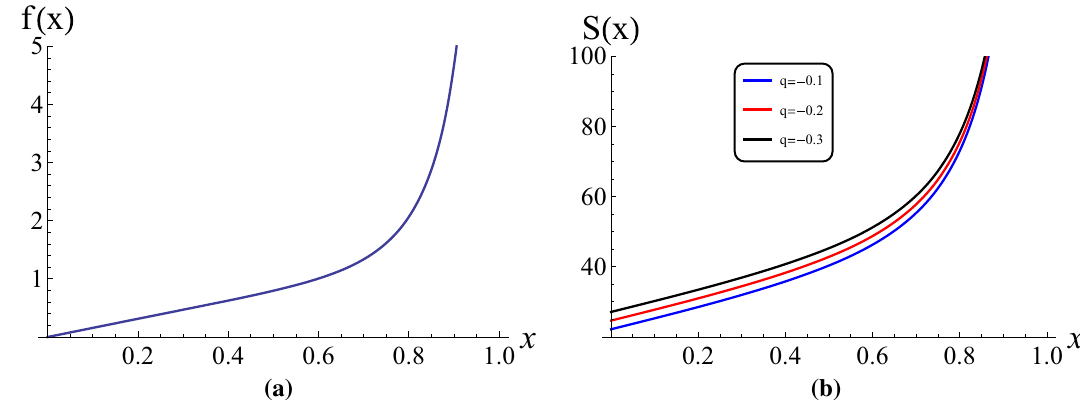
Fig. 5 The same as Fig. 4, but for the metric function f ( x ) and entropy S ( x